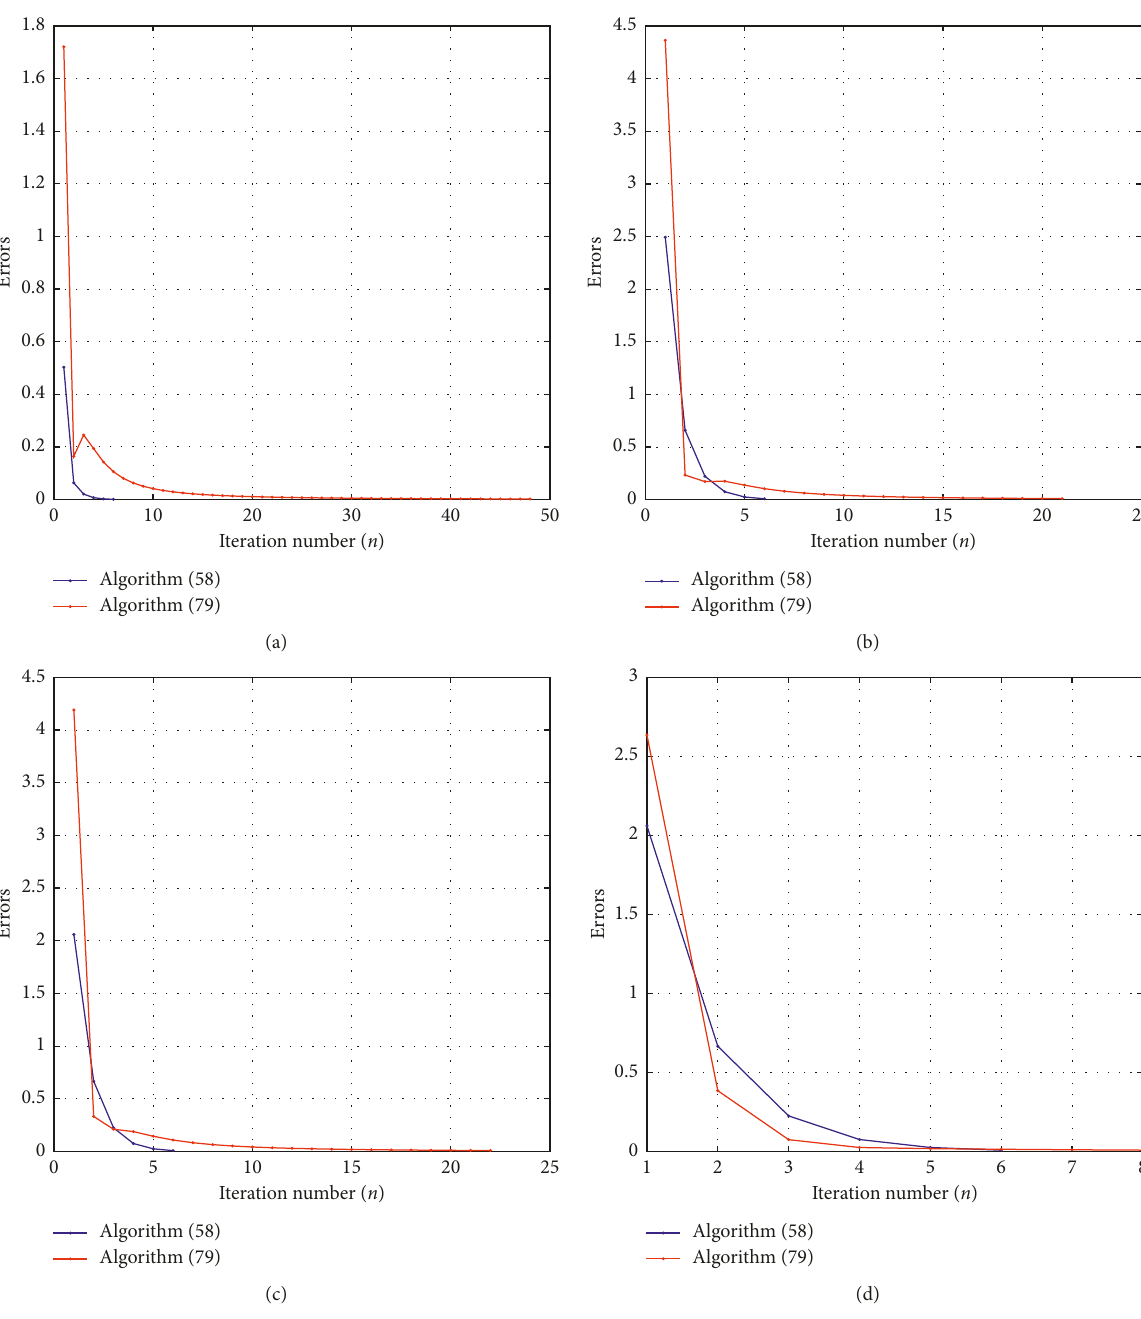
Figure 1: Errors vs iteration numbers n : Case 1 (a); Case 2 (b); Case 3 (c); Case 4